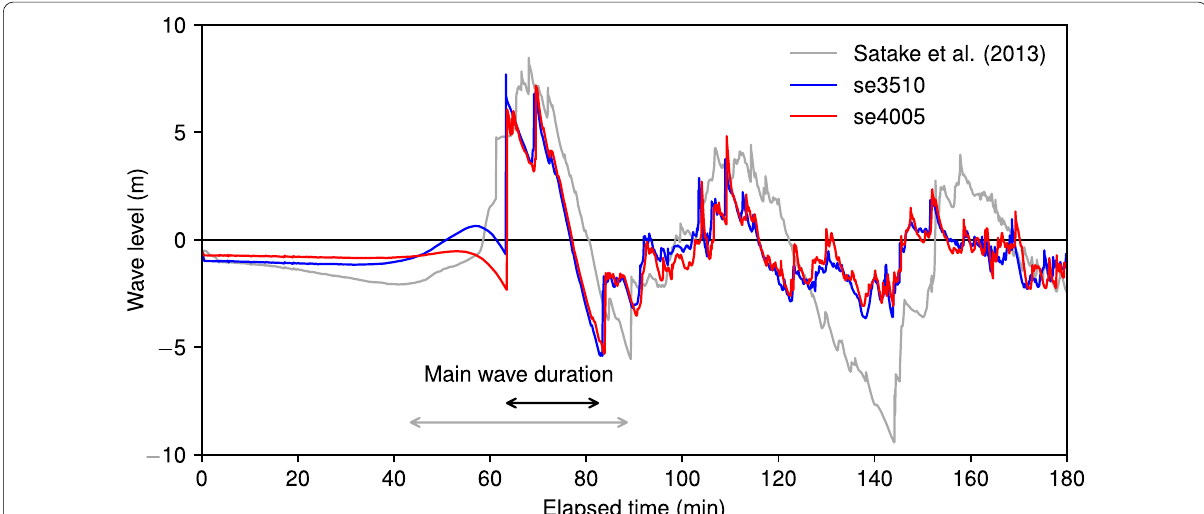
Fig. 10 Waveforms recorded on a virtual tide station, SJN1. Along with scenarios se3510 and se4005, a waveform associated with the source model of Satake et al. (2013) is shown as a reference. Black and gray arrows indicate the duration of the main wave associated with hypothetical models (se3510 and se4005) and the reference simulation,